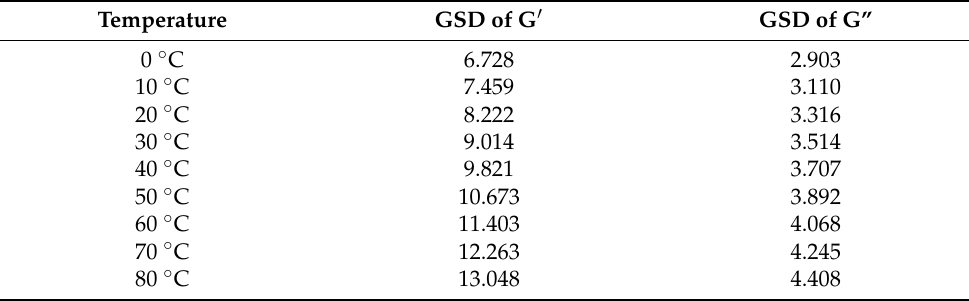
Table 1. Geometric standard deviation (GSD) values of storage and loss moduli